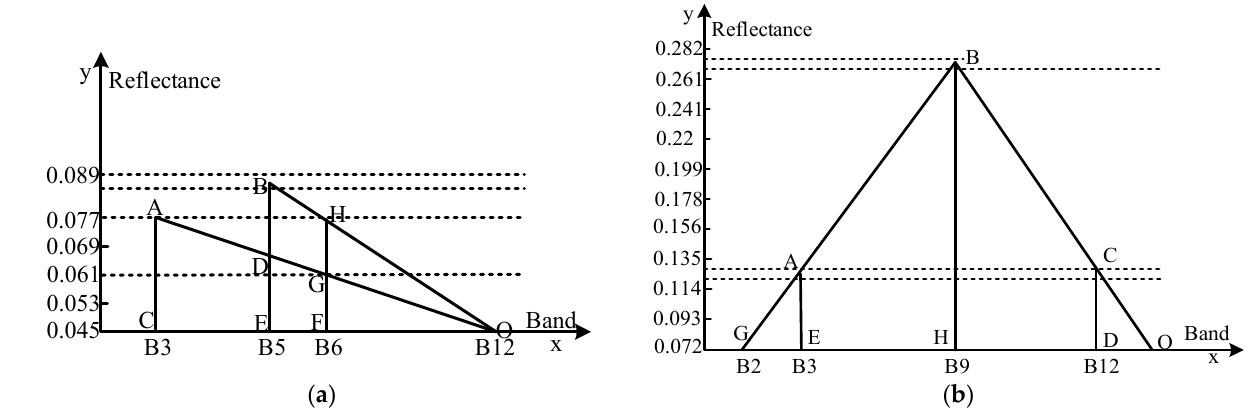
Figure 4. Triangles of two different water bodies: ( a ) Type I water bodies, ( b ) Type II water bodies. The ordinate y shows average values of the difference between the maximum and minimum reflectance values corresponding to bands for water body samples in each band of the Sentinel − 2A image. The abscissa X represents spectral bands of Sentinel − 2A. The dotted lines represent extension lines based on the reflectance values of the respective bands. A–H are intersections of bands and corresponding to the ordinate y.